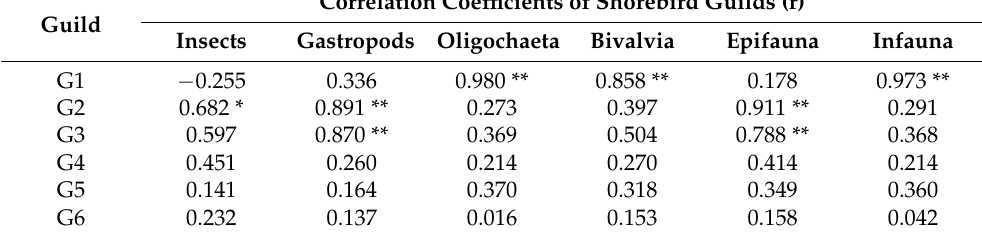
* indicates p < 0.05, ** indicates p <